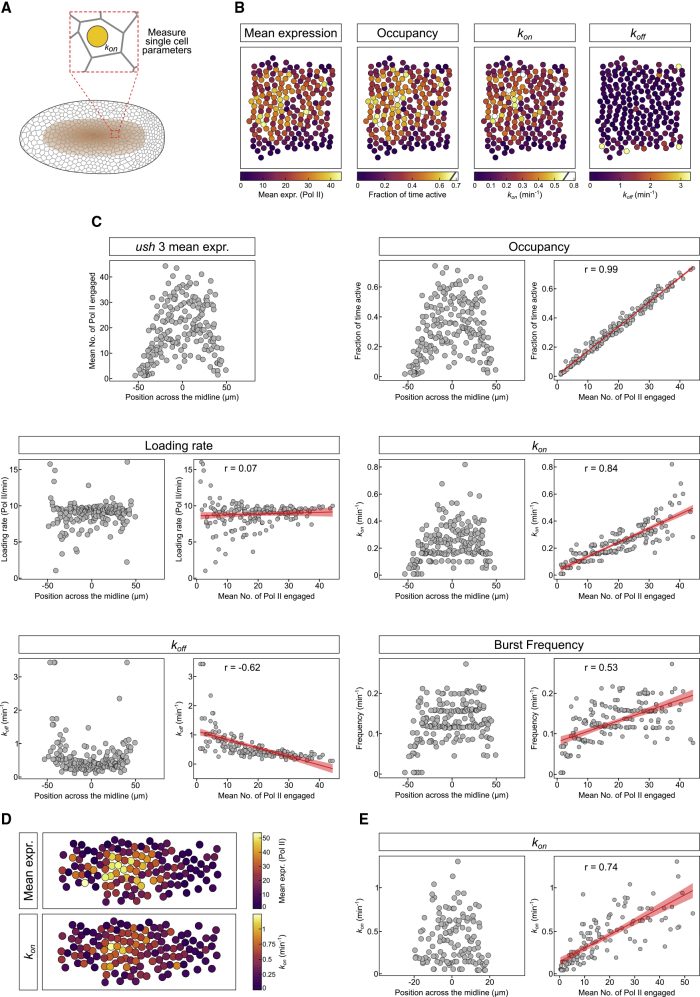
BMP Signaling Level Is Decoded by Modulating kon(A) Schematic of a Drosophila embryo indicating the ush expression domain and single-cell analysis of transcription parameters.(B) Expression domain of a representative ush embryo shown as heatmaps with nuclei false colored according to their mean expression and single-cell transcription parameters for occupancy, kon and koff.(C) Mean expression values of ush plotted according to the nuclear position across the dorsal midline for one representative embryo. Burst kinetic parameters of single ush nuclei plotted based on dorsal midline position (left) and against mean expression (right) for promoter occupancy, loading rate, kon, koff, and burst frequency. See Figure S4A.(D) Heatmaps as in (B) showing mean expression and kon for a representative hnt expression domain.(E) Single-cell kon values plotted based on their position (left) and against their mean expression (right). See Figures S4B–S4D for other hnt parameters.Pearson correlation coefficient is shown for each pair of variables between burst parameter and mean expression. Linear regression is shown ± 95% confidence intervals. n = 195 nuclei for ush (189 for loading rate) and 131 nuclei for hnt single-cell parameters. See also Figure S4.